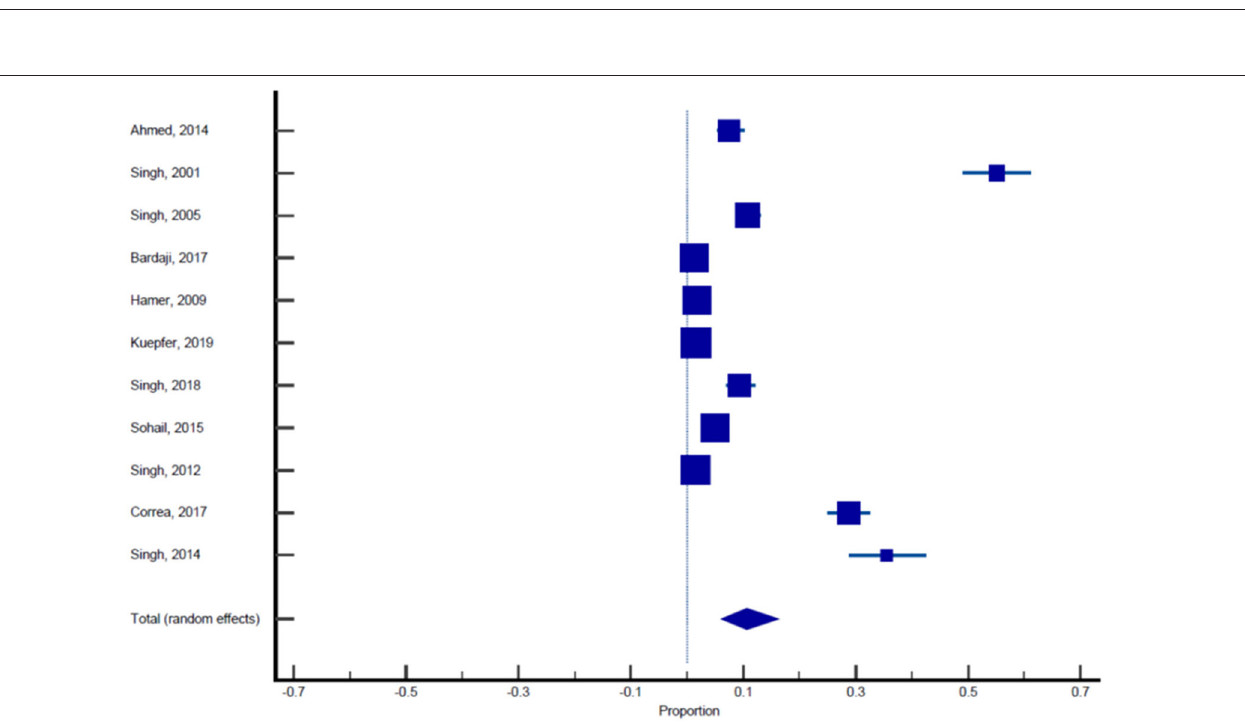
FIGURE 4 | Forest plot showing prevalence of malaria in asymptomatic pregnant females, the blue diamond indicates the pooled prevalence and the horizontal line shows the 95% confidence interval.